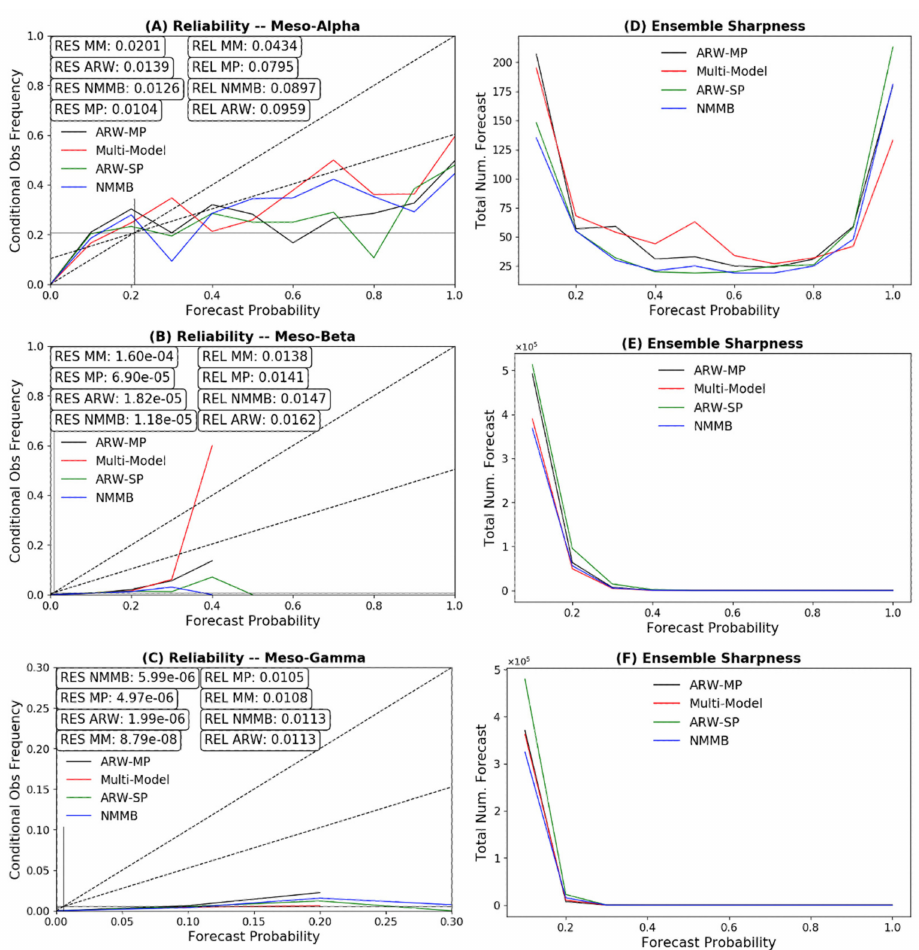
Figure 7. Reliability diagrams for ( A ) meso-alpha, ( B ) meso-beta, and ( C ) meso-gamma scales and corresponding sharpness plots for ( D ) meso-alpha, ( E ) meso-beta, and ( F ) meso-gamma scales. A “no-skill” line halfway between perfect reliability and the climatological base rate is also plotted for reference. Reliability diagrams for meso-beta and meso-gamma are not full diagrams given the low-probability nature of the contour plots at these